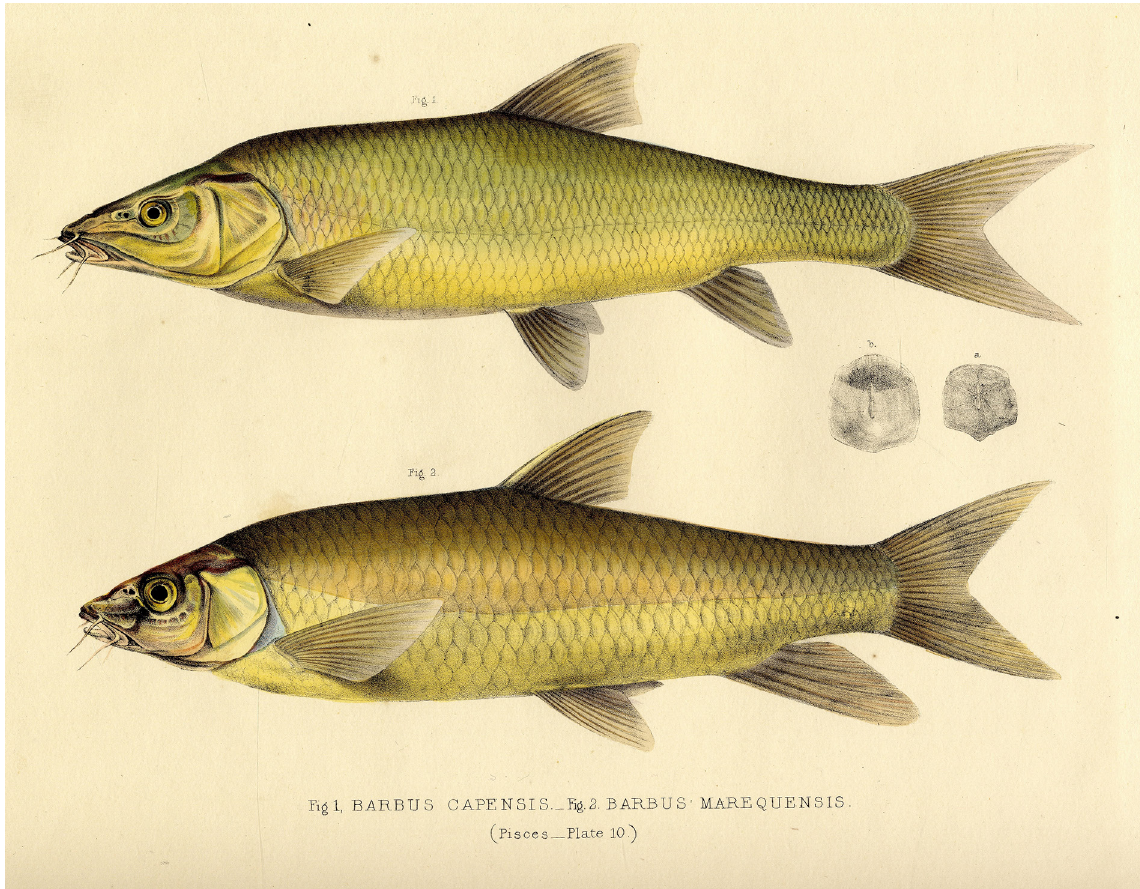
Fig. 6. Andrew Smith’s 1841 Plate X illustrating Barbus capensis (above) and Barbus marequensis (below). Photo credit: Cory Library, Rhodes University,